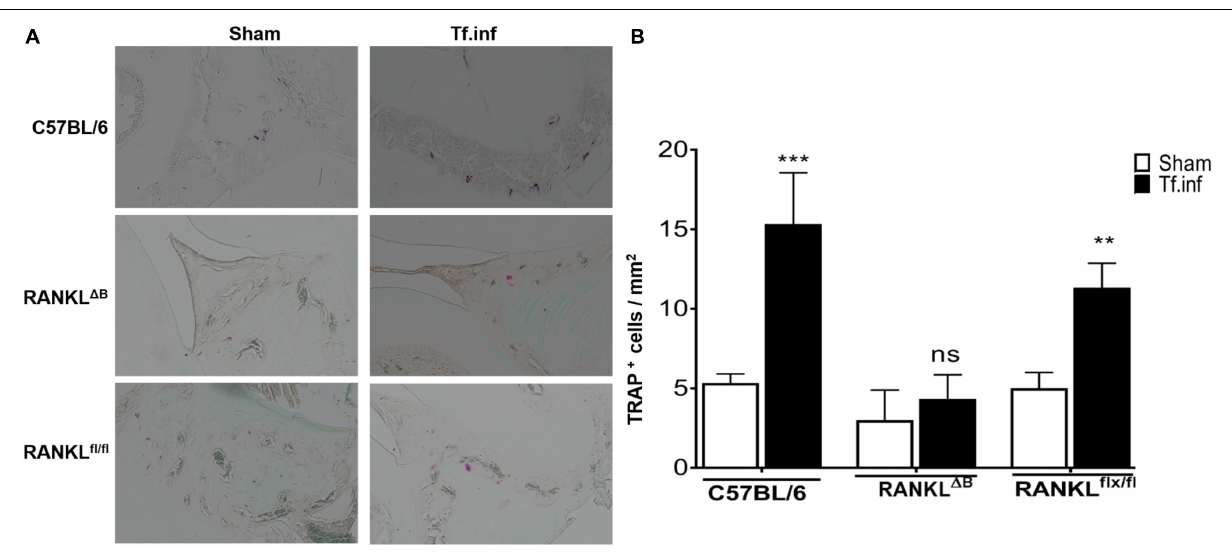
FIGURE 6 | Alveolar bone loss correlates with osteoclastic activity. (A) Representative histological sections showing TRAP + cells from T. forsythia (Tf. Inf ) and sham (Sham) infected mice ( × 400). (B) Average number of TRAP + cells in 10 high-power magnification fields/slide ( n = 4 mice/group). ** p < 0.01, *** p < 0.001; Tf. Inf vs